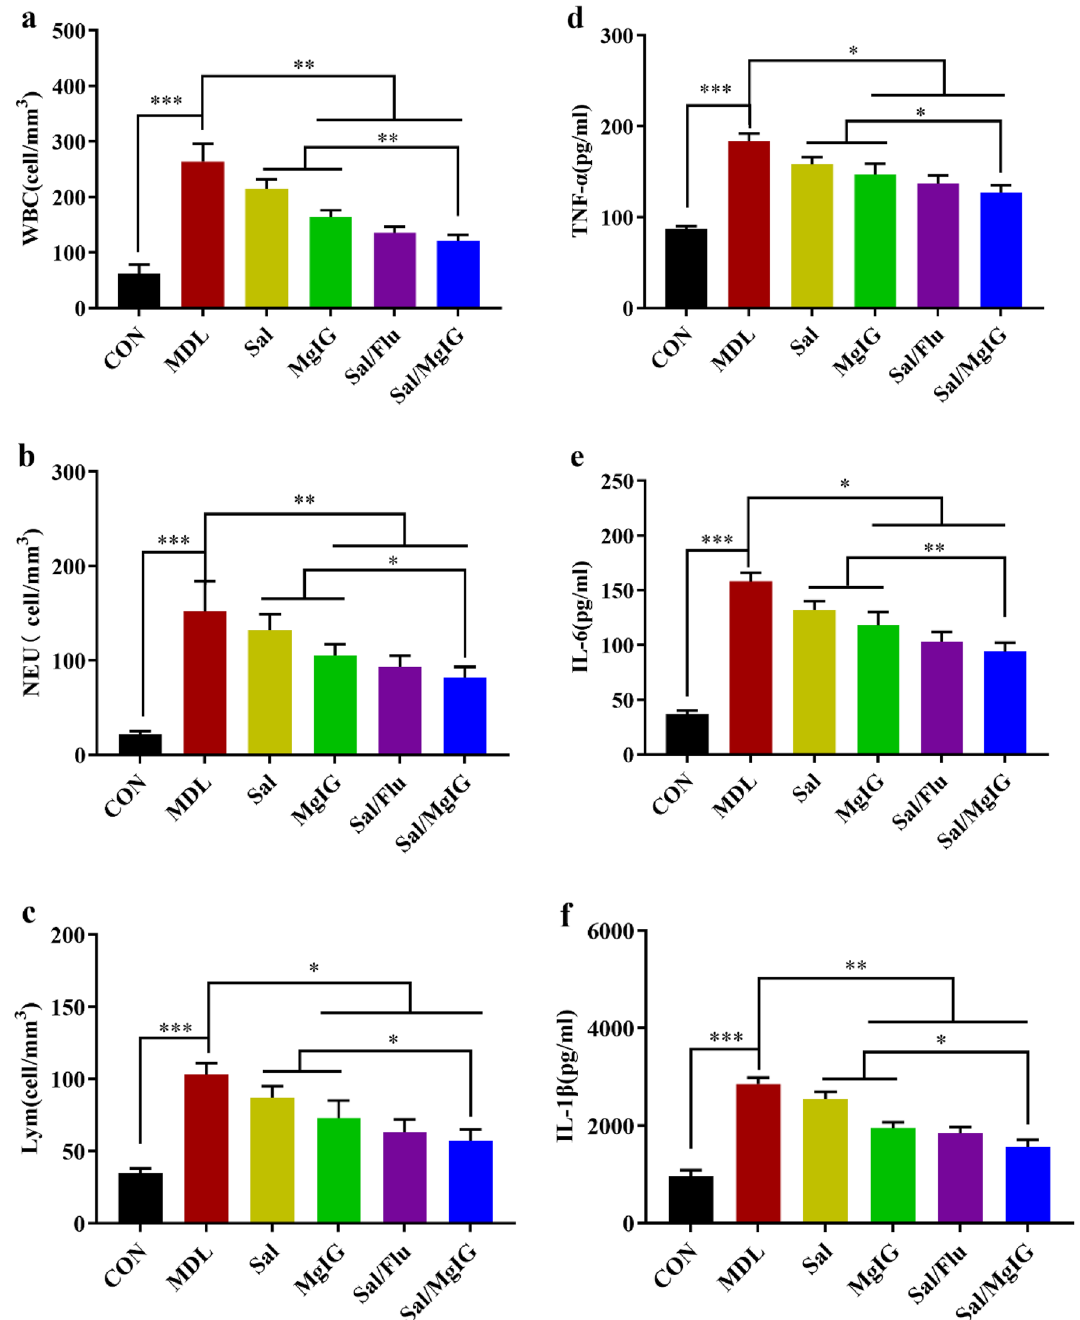
Figure 2. Effects of Sal and/or MgIG on the inflammatory cells in BALF and the levels of inflammatory cytokines in the serum of COPD rats. ( a ) Number of white blood cells in the BALF of rats after 15-day different treatment. ( b ) Number of neutrophils in BALF of rats after 15-day different treatment. ( c ) Number of lymphocytes in BALF of rats after 15-day different treatment. The levels of TNF-α ( d ), IL-6 ( e ) and IL-1β ( f ) in the serum of rats after 15-day different treatment were shown as above. All data were presented as mean ± standard deviation (n = 10 in each group). Statistical significance of differences were determined by one- way ANOVA. ***p < 0.001, **p < 0.01 and *p < 0.05 was considered to indicate a statistically significant